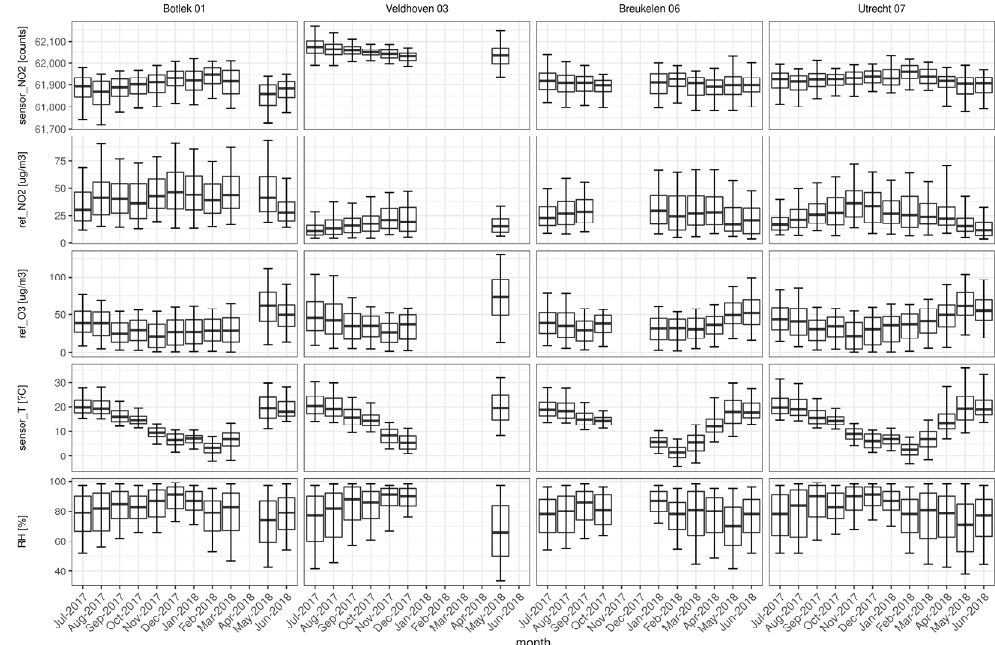
Figure 2. Box-and-whisker plots of reference measurements and predictors used in the calibration of the sensors. The horizontal line indicates the median. The boxes and whiskers show, respectively 25% to 75%, and 5% to 95% of the data.